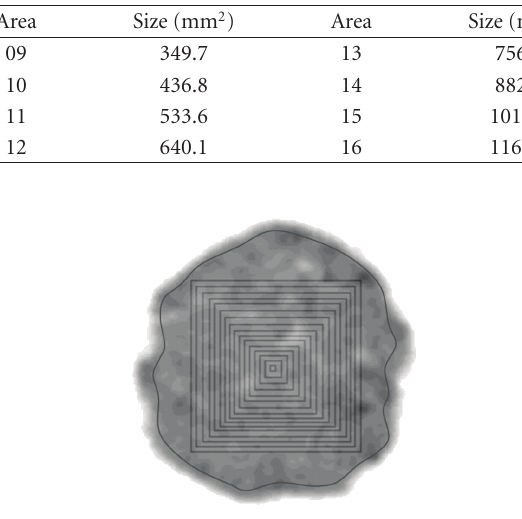
Figure 2: Schematic drawn of the area construction on the tomographic images. The area next to edge corresponds to the free area (FA). Darker regions represent higher soil bulk density